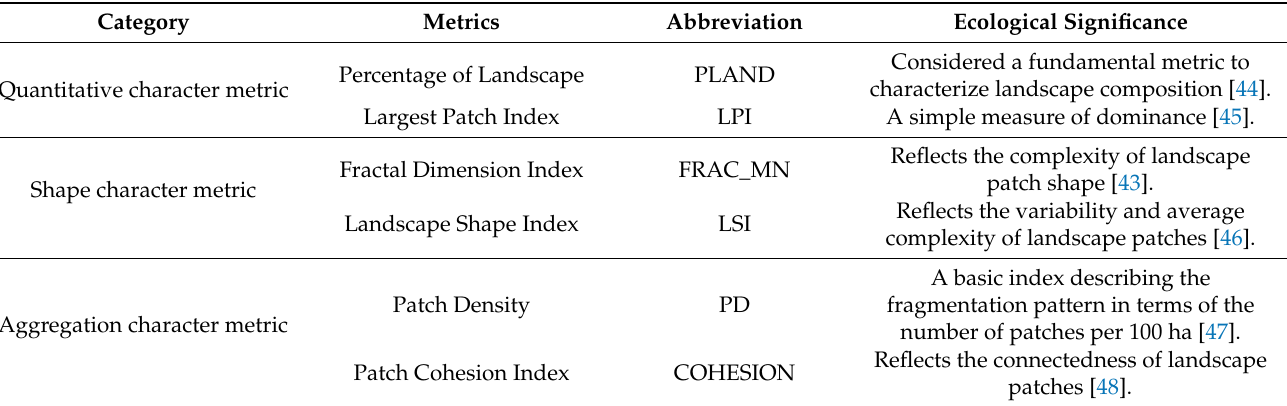
Table 2. The landscape indices and their ecological